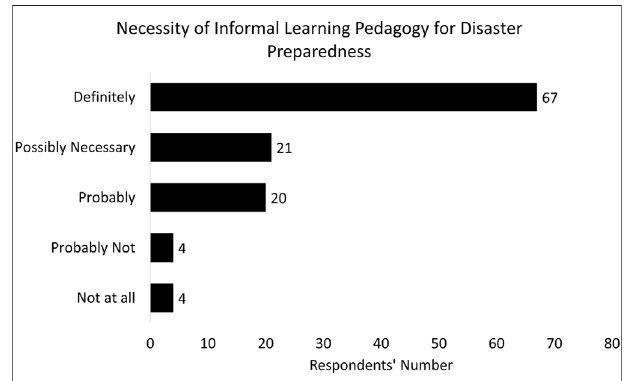
Figure 4 . Previous studies have highlighted that a household with children and multiple family members are more likely to be evacuated during disasters such as a hurricane.